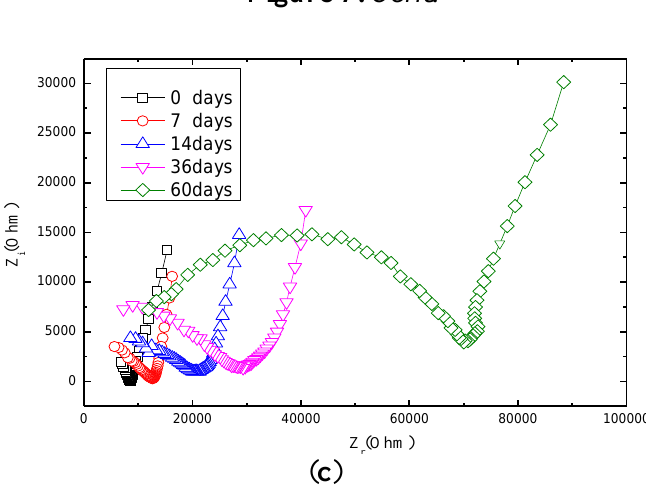
Table 1. The fitting result of R